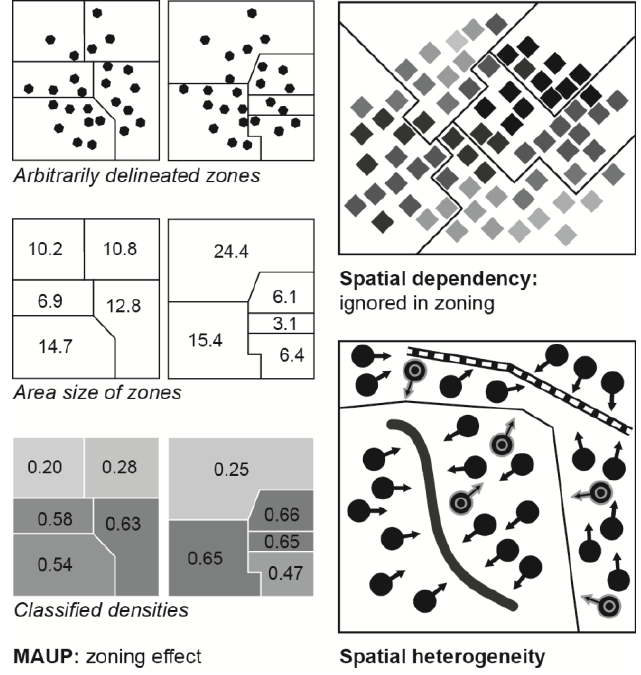
Figure 2. MAUP (Modifiable Areal Unit Problem), spatial dependency and spatial heterogeneity as relevant spatial implications in transport modeling.